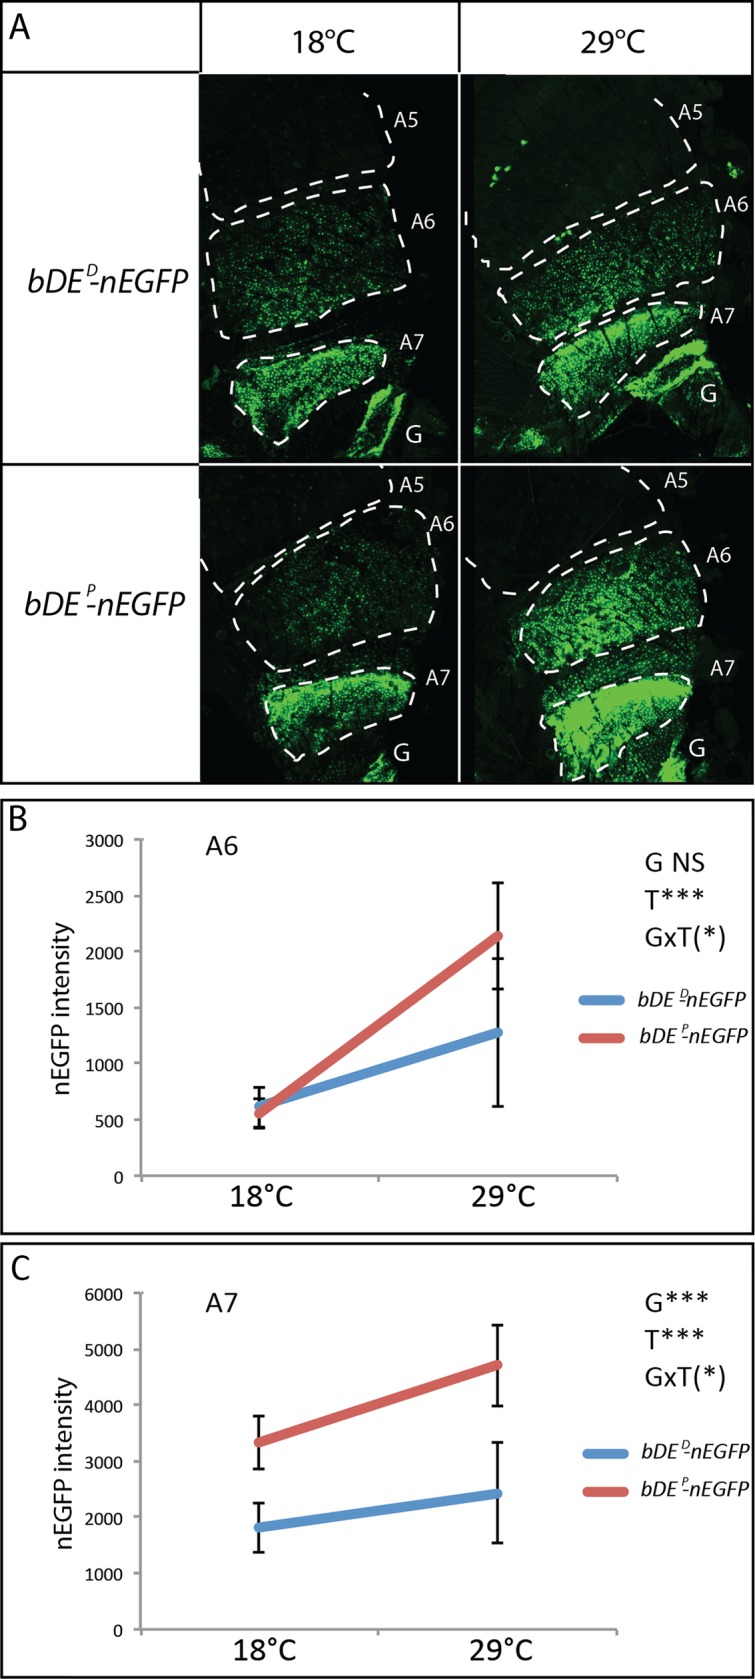
The bDE activity of the Dark and the Pale line is different and modulated by temperature.A: Activity of bDE from the Dark or Pale lines at 18°C or 29°C in young female pupae (bDED-nEGFP and bDEP-nEGFP homozygous transgenic lines), visualized through nEGFP intensity. Segments A5, A6 and A7 are delimited with dashed lines. G: genitalia. B: Quantification of nEGFP in A6 (n = 10 per genotype and per temperature) showing a significant effect of the temperature (T) and a marginally significant effect of the genotype by temperature interaction (GxT). Non-parametric ANOVA (Sheirer-Ray-Hare test). (*) 0.05<p<0.1; ***: p<0.001. NS: non significant. C: Quantification of nEGFP in A7 (n = 10 per genotype and per temperature) showing significant effects of the genotype (G) and the temperature (T). A marginally significant effect of the genotype by temperature interaction (GxT) is also observed. Statistical test: two-way ANOVA. (*): 0.05<p<0.1; ***: p<0.001.